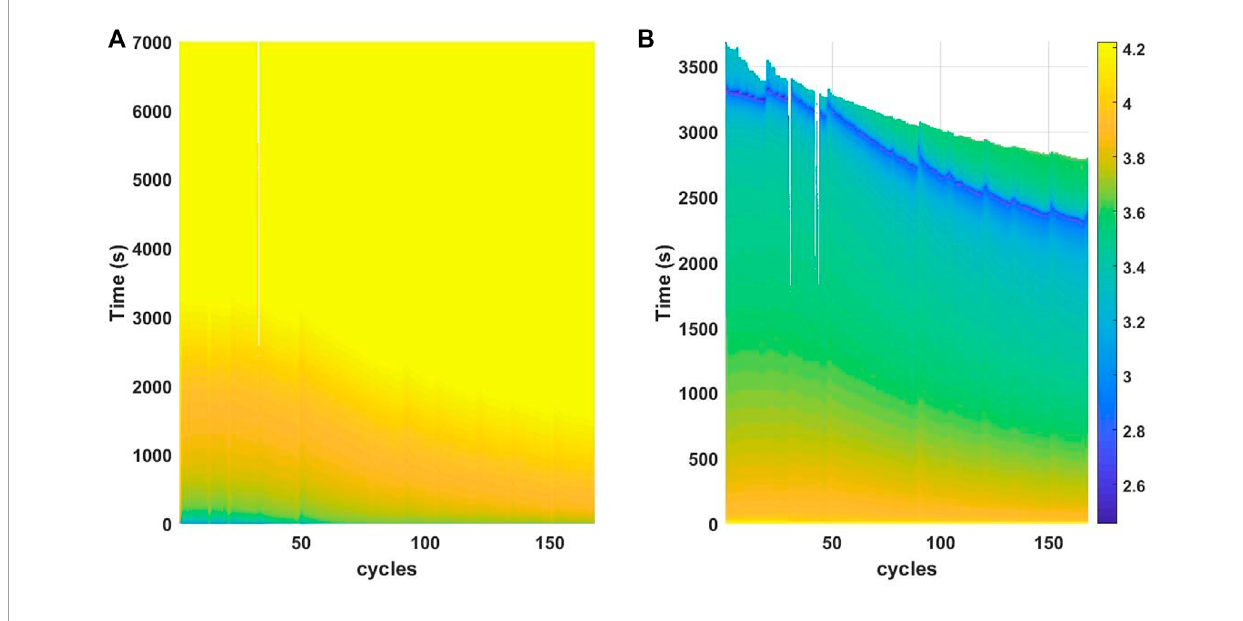
FIGURE 3 Battery voltage in relation to time and number of cycles during (A) charging and (B) discharging cycle.